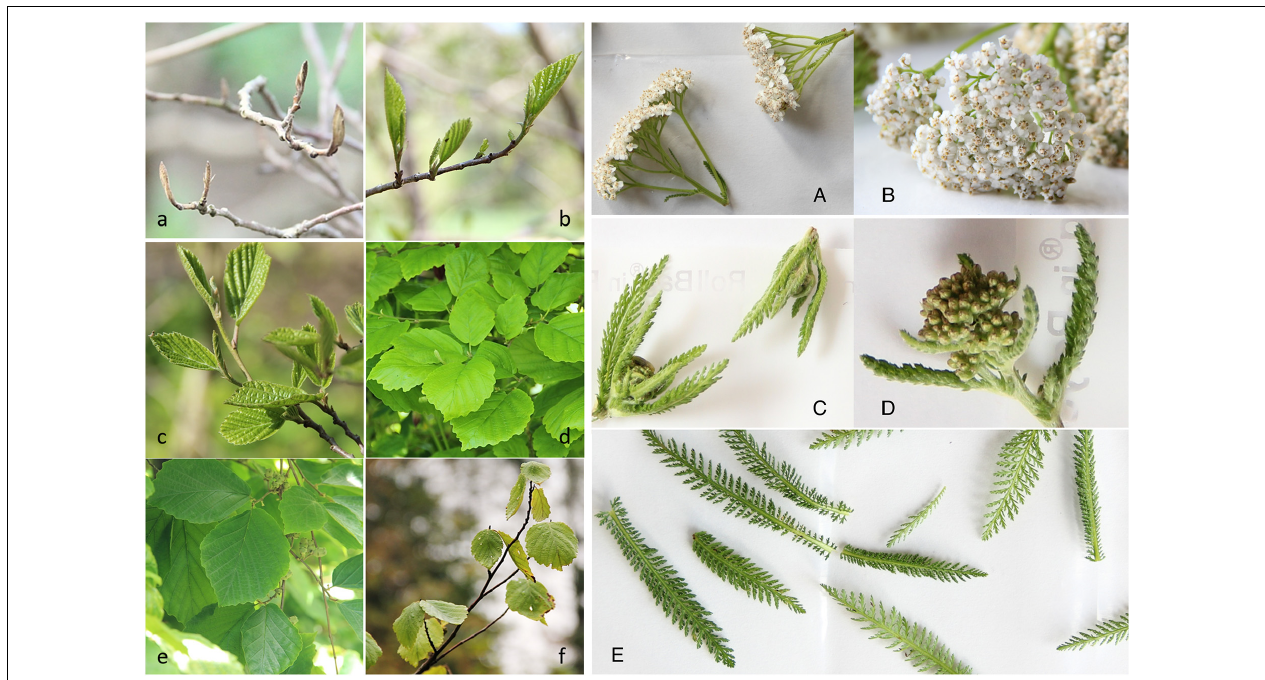
FIGURE 1 | Plant organs of Hamamelis virginiana and Achillea millefolium studied in 2016. Left panel (a–f) : Hamamelis ; (a) : Leaf buds (06 Apr); (b) : Leaf (18 Apr); (c) : Leaf (04 May); (d) : Leaf (20 May); (e) : Leaf (04 Jul); (f) : Leaf (20 Sep). Right panel (A–E) : Achillea : (A,B) : open flowers; (C,D) : Flower buds with upper young leaves; and (E) :